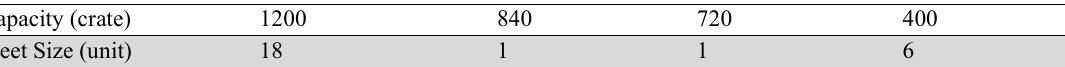
Fleet size for each vehicle capacity Capacity (crate) 1200 840 720 400 Fleet Size (unit) 18 1 1